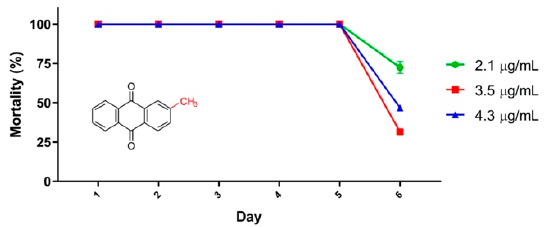
Figure 3. Tectoquinone ( 4 ; 2.1 µg/mL, 3.5 µg/mL and 4.3 µg/mL) small-scale field residual larvicide effect over 6 days. Larvae mortality was recorded every 24 h, with daily larvae replacement. DMSO (negative control) mortality < 5%. Temephos (positive control) mortality decreased from 99% (Day 1) to 85% (Day 6) and to <56% (Day 9). Error bars = standard error of the mortality mean value.